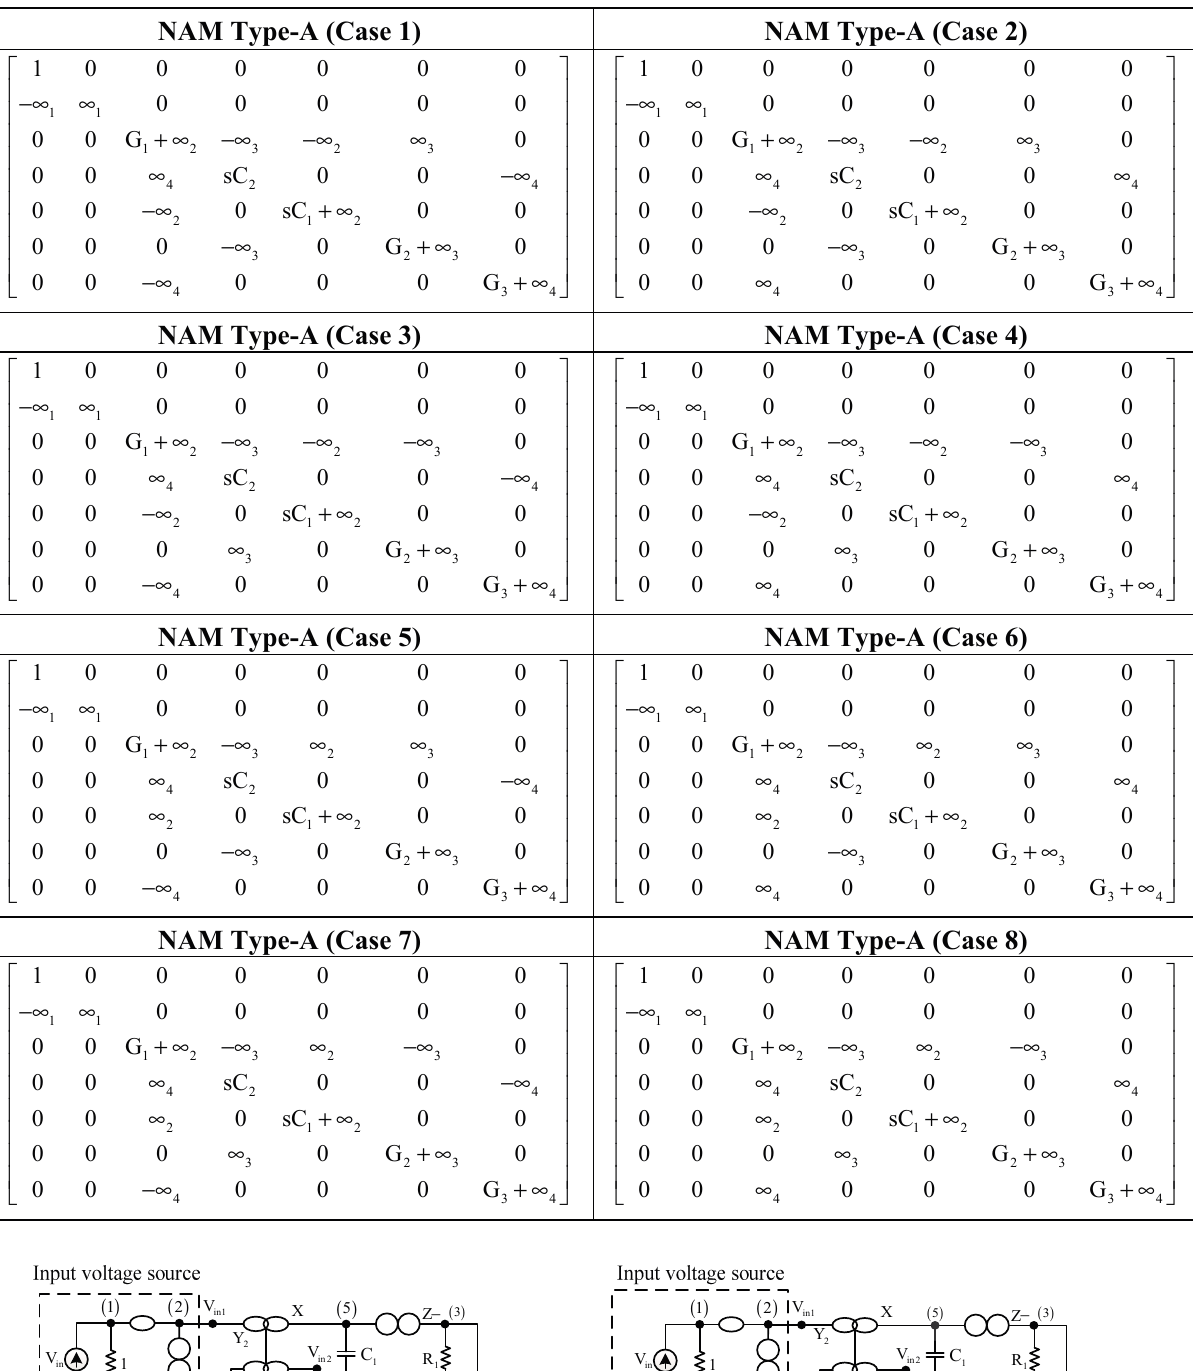
Table 1. Eight cases of expanding NAM